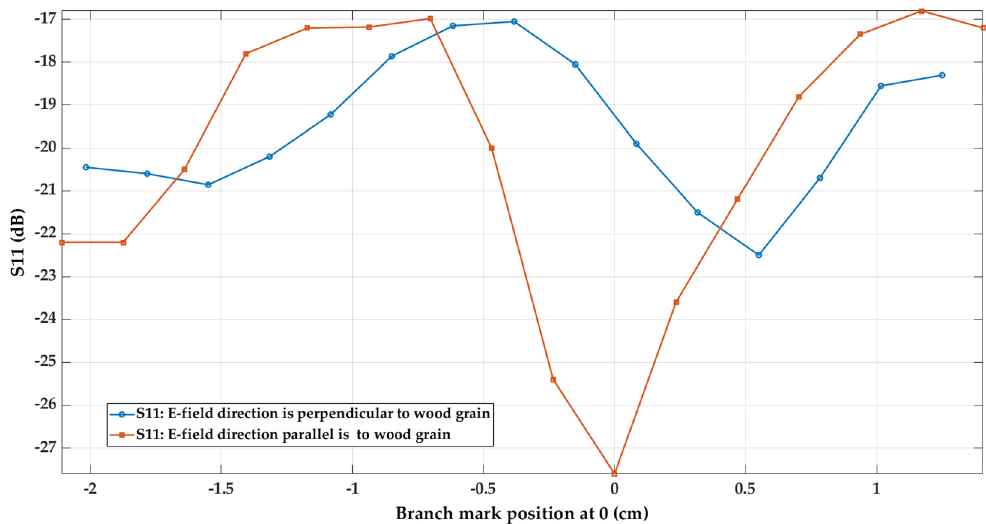
Figure 8. The S 11 reflection coefficient profile for measurements across the branch mark at 4.4 GHz using both parallel and perpendicular polarizations.